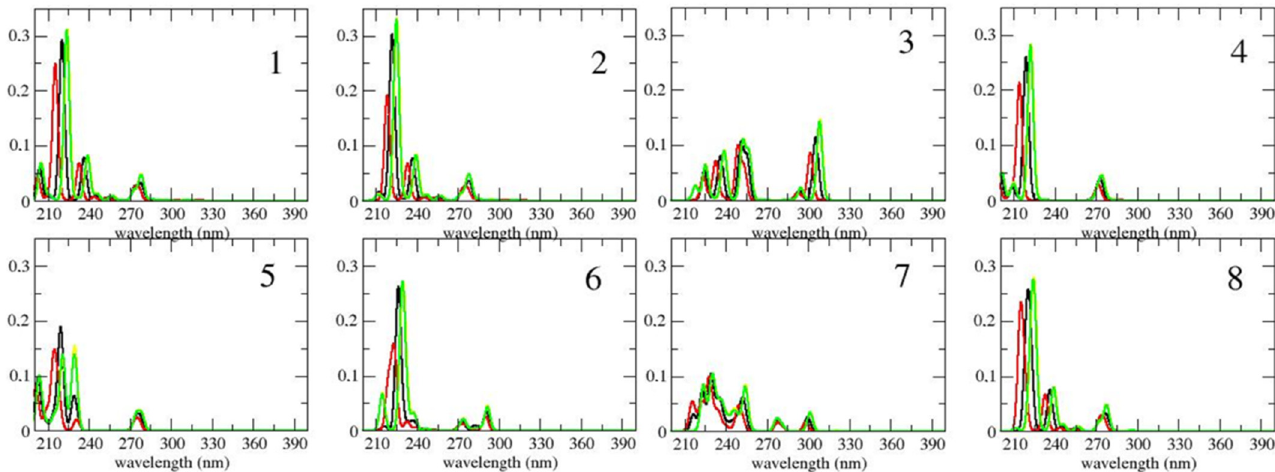
Figure 2. Collection of the calculated spectra of quinolines ( 1 – 8 ) in different n -hexane (red line), chloroform (black line), methanol (yellow line), and 2-propanol (green line). Intensities correspond to oscillator strengths reported in arbitrary